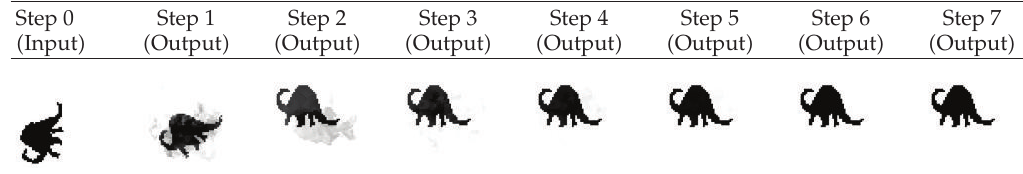
Table 14: Network recall using a di ff erent planar rotation: 275 ◦